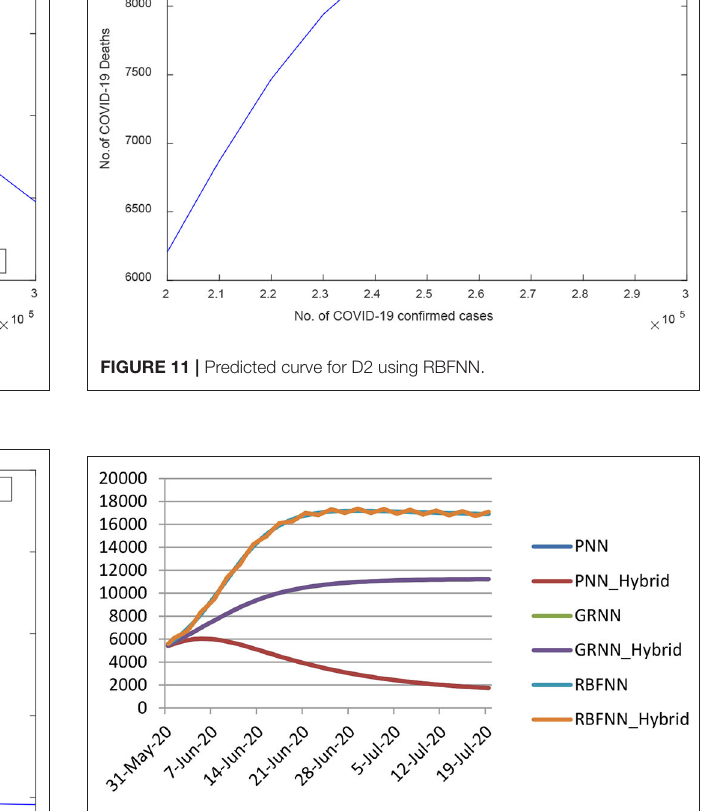
FIGURE 12 | Comparison of SNN models and hybrid models for